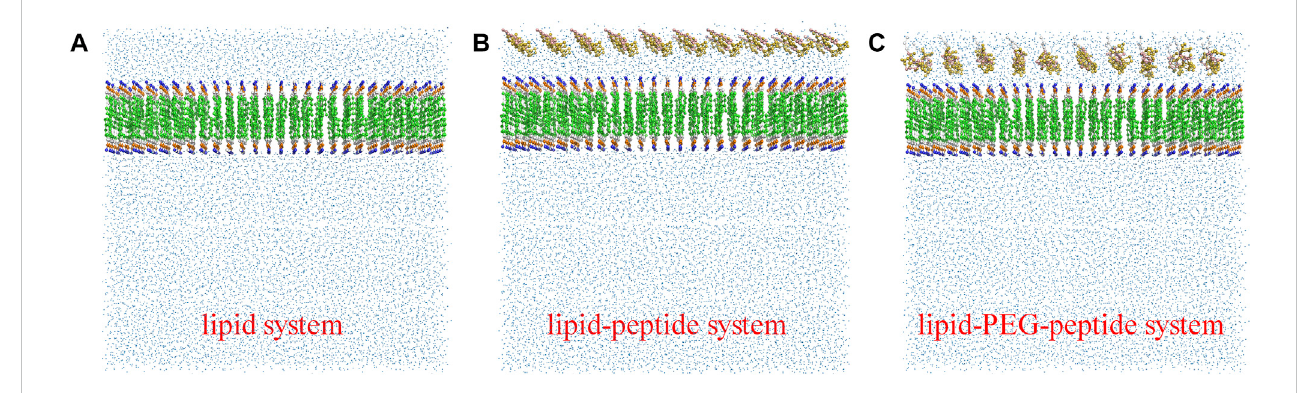
FIGURE 1 The coarse-grained models of lipid system (A) , lipid-peptide system (B) and lipid-PEG-peptide system (C)